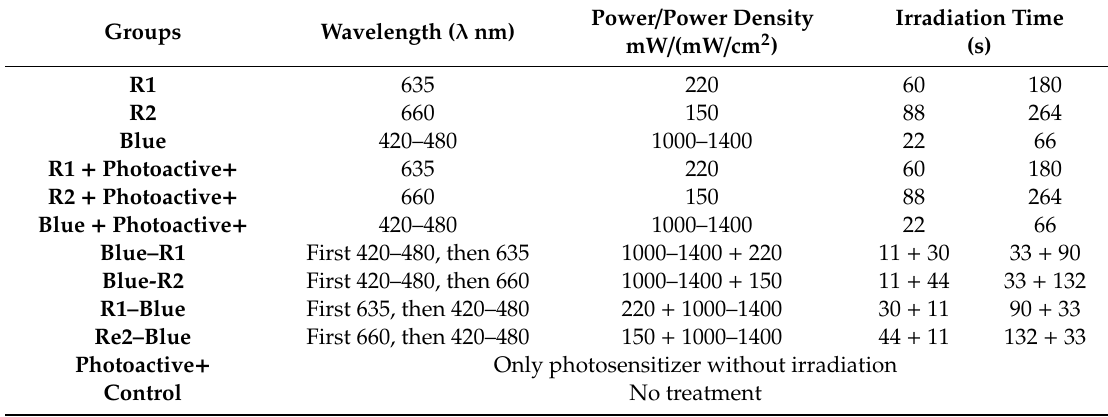
Table 1. Experimental